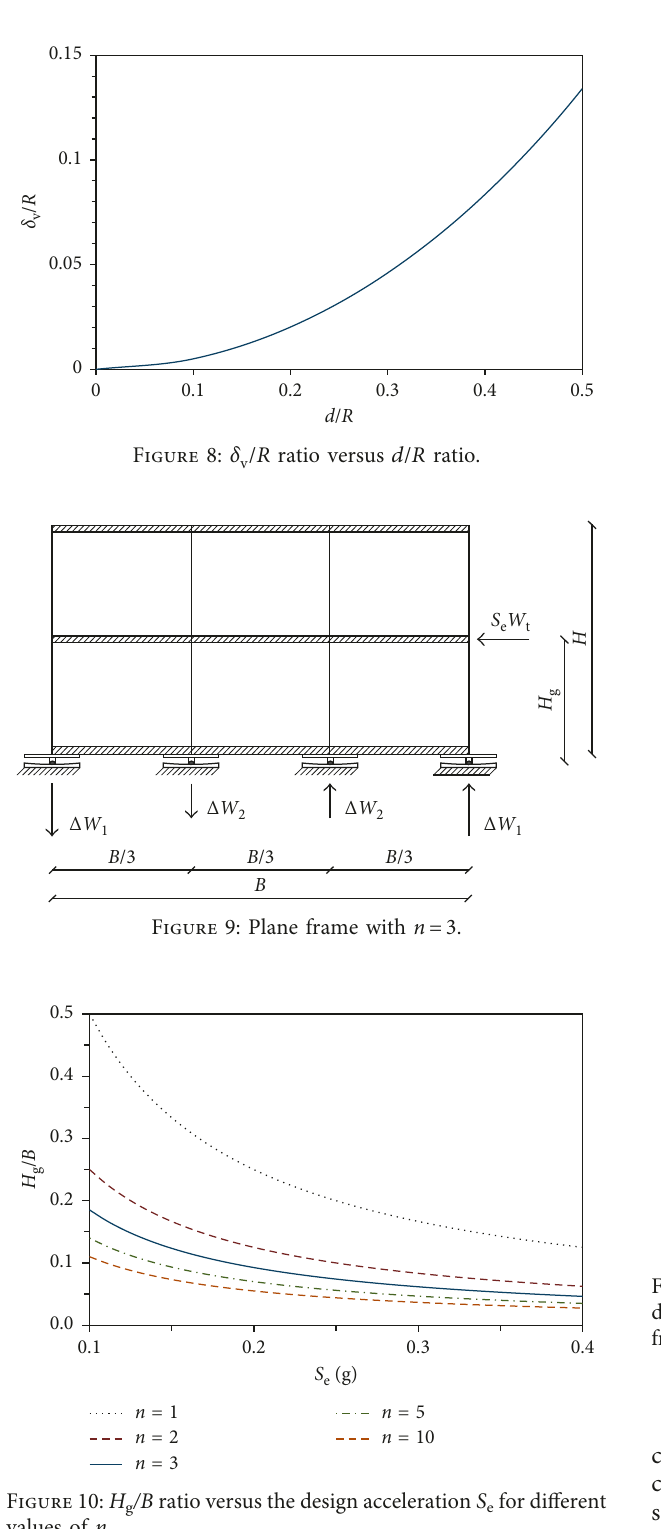
Figure 10: H g /B ratio versus the design acceleration S e for different values of n .